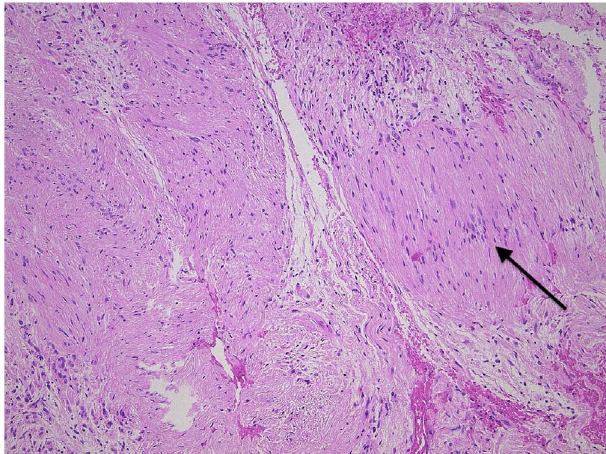
Figure 2. Typical picture of a schwannoma, showing the nuclear palisading